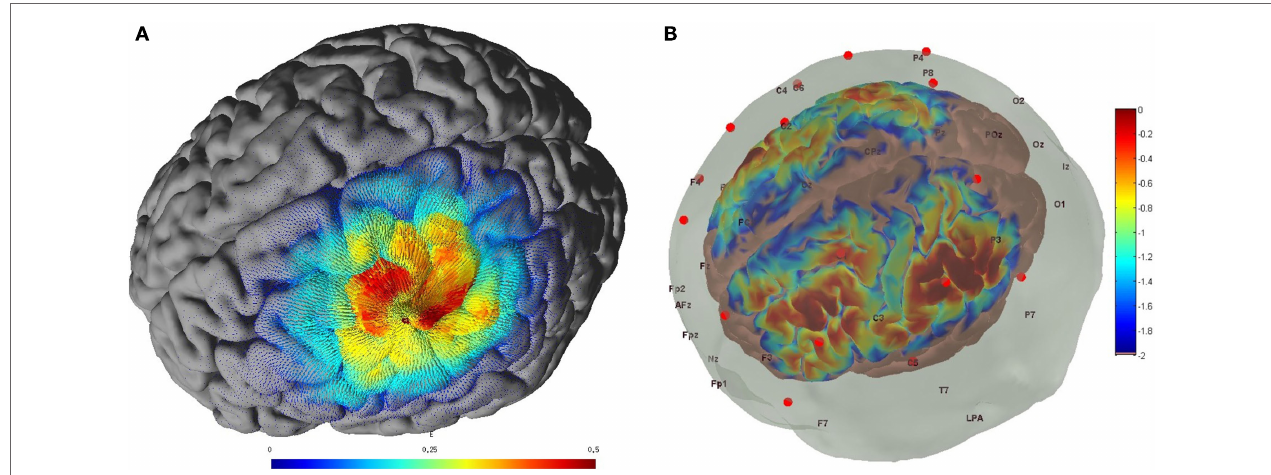
FiGUre 2 | (a) Electric field estimated at the gray matter surface due to 2-mA HD-tDCS (electrode montage shown in Figure 1 ). (B) Measurement sensitivity distribution of the fNIRS probe (montage shown in Figure 1 ) at gray matter surface.